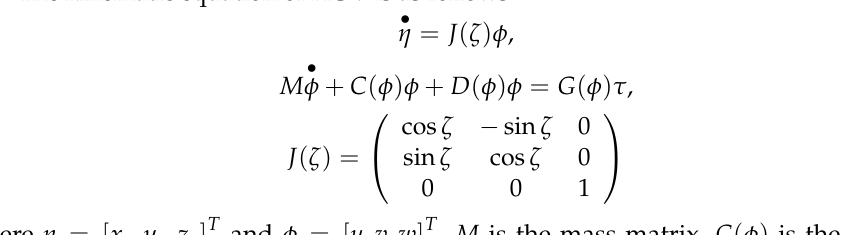
Figure 1. Inertial coordinate system and motion coordinate system of AUV .